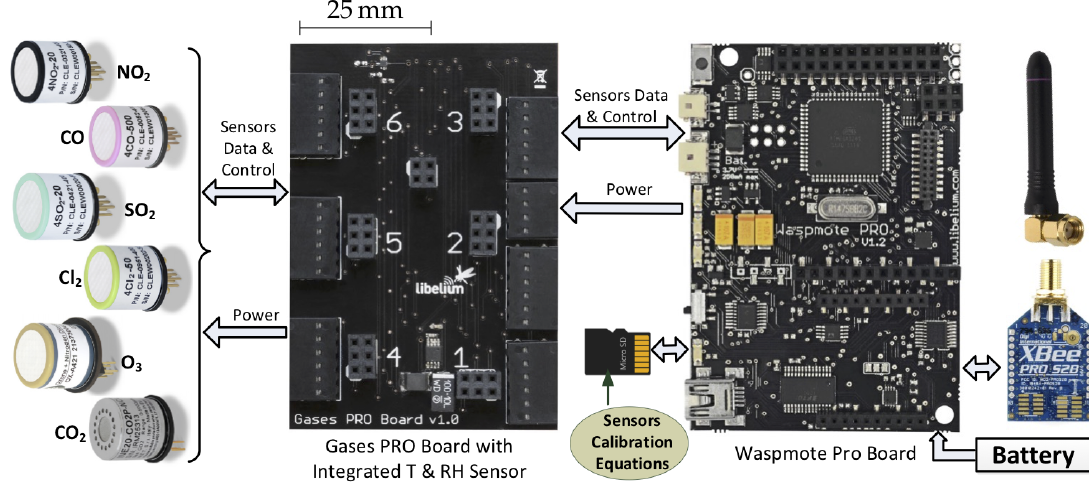
Figure 1. Sensor node for air-quality monitoring.